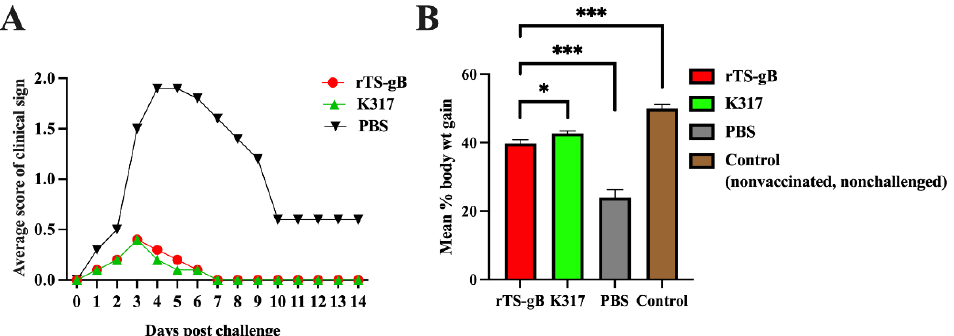
Figure 5. Clinical protection of rTS-gB against virulent ILTV challenge in chickens. Four-week-old SPF chickens were vaccinated with rTS-gB, K317, or PBS and challenged with the virulent ILTV WG strain at 14 dpi. The clinical signs were recorded daily, and the body weights were measured prior to challenge and at 10 dpc. The average clinical scores for each group of chickens ( A ) and the percentage of weight gain from prior to challenge to 10 dpc ( B ) were plotted. * p < 0.05; ** p < 0.01. *** p < 0.001. ns, not